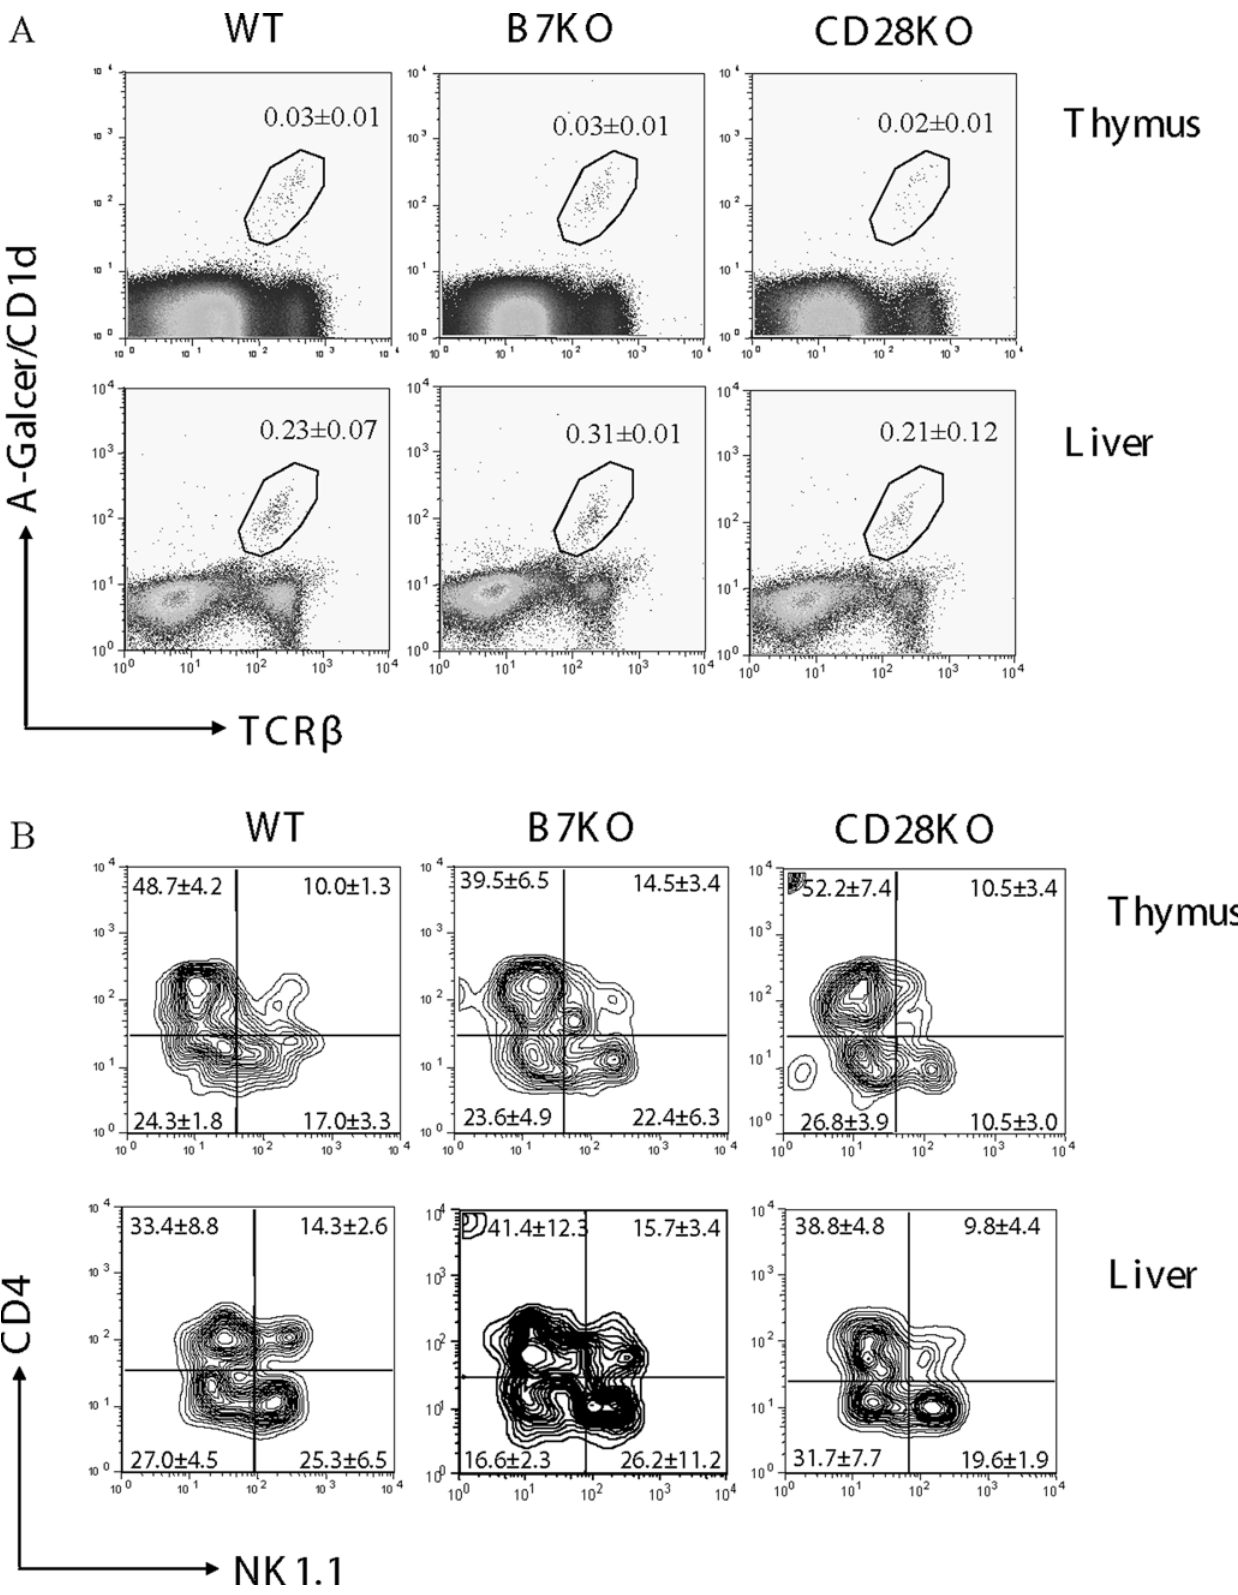
Figure 4. B7- and CD28-deficiency does not affect the generation of immature iV a 14 NKT cells in young mice. Total lymphocytes from the thymus (upper panel) and liver (lower panel) of 8-day old WT (left), B7-1/2- (middle) and CD28- (right) deficient mice were analyzed. The numbers represent the percentage (Mean 6 SD, n=4) of iV a 14 NKT cells (A) and the percentage (Mean 6 SD, n=4) of individual subsets from gated iV a 14 NKT cells (B). One representative profile from each group is shown.